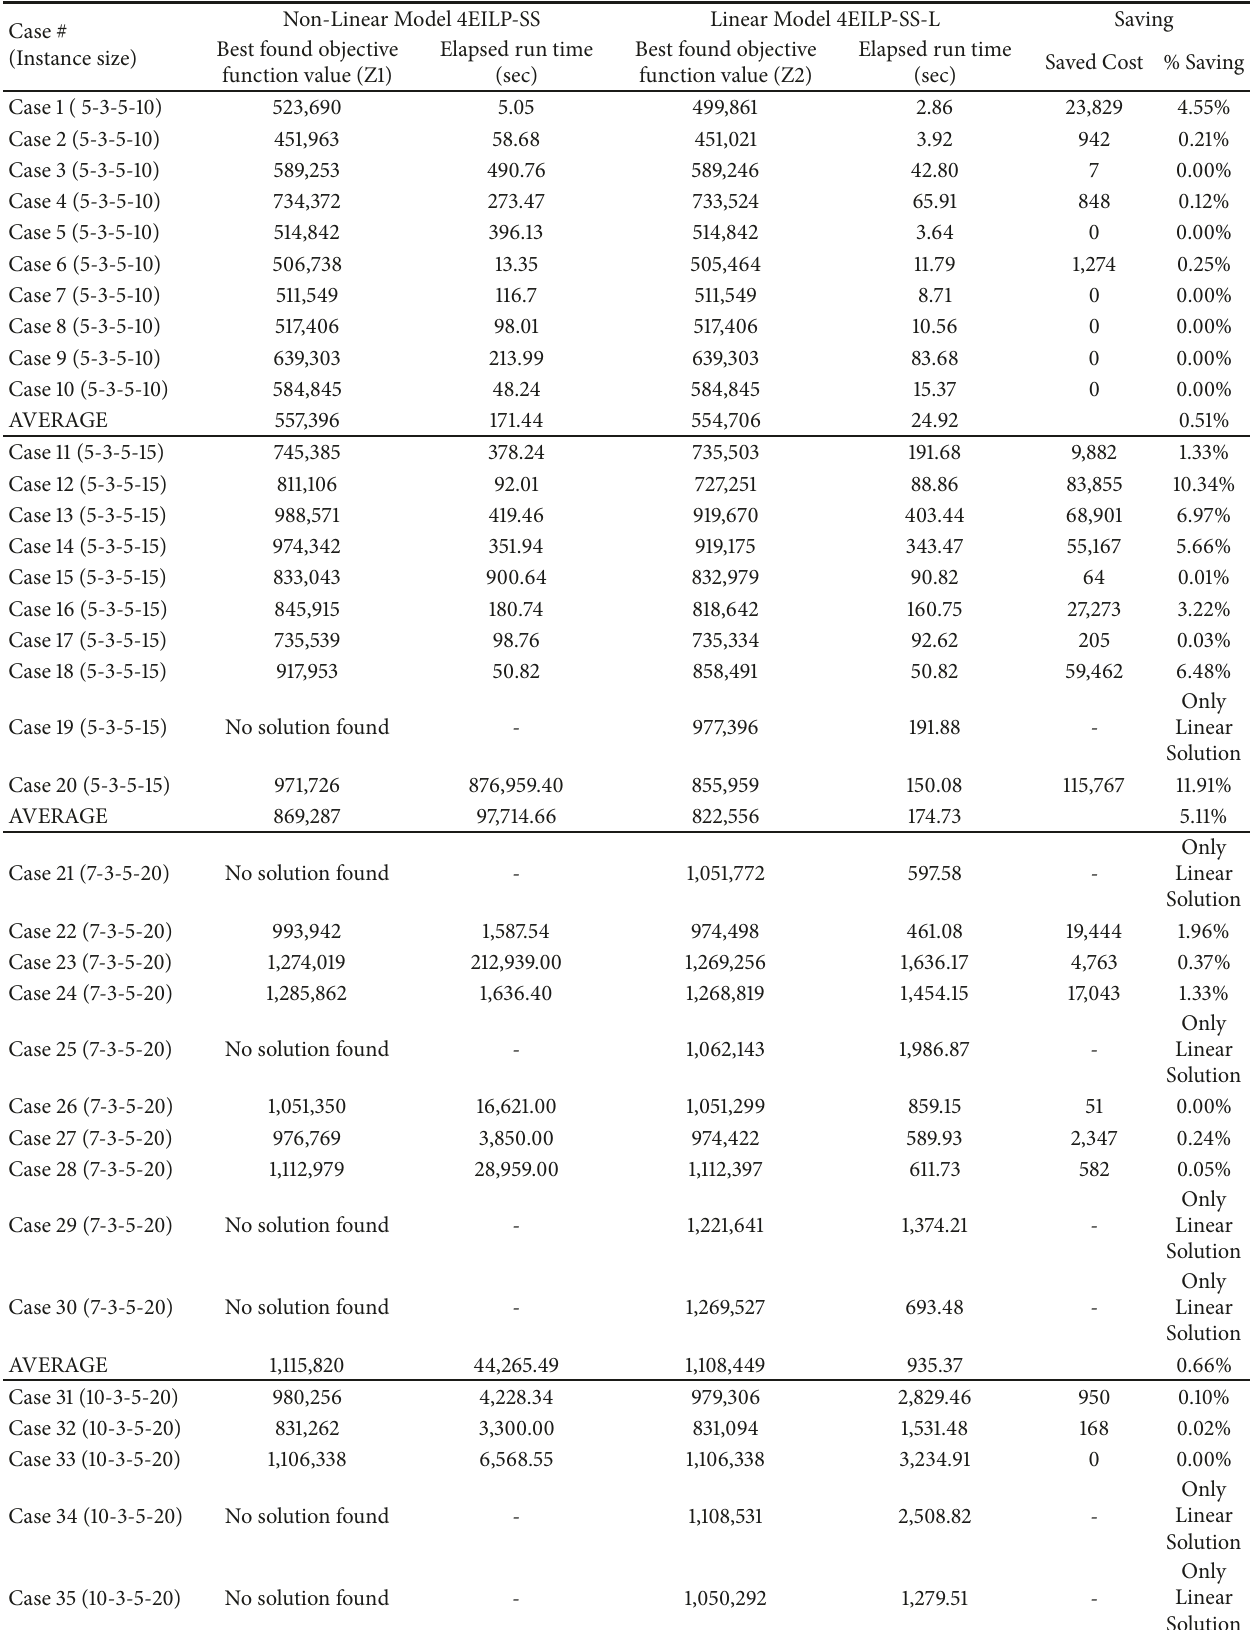
Table 7: Results of applying the nonlinear model and the linear model considering a service level of